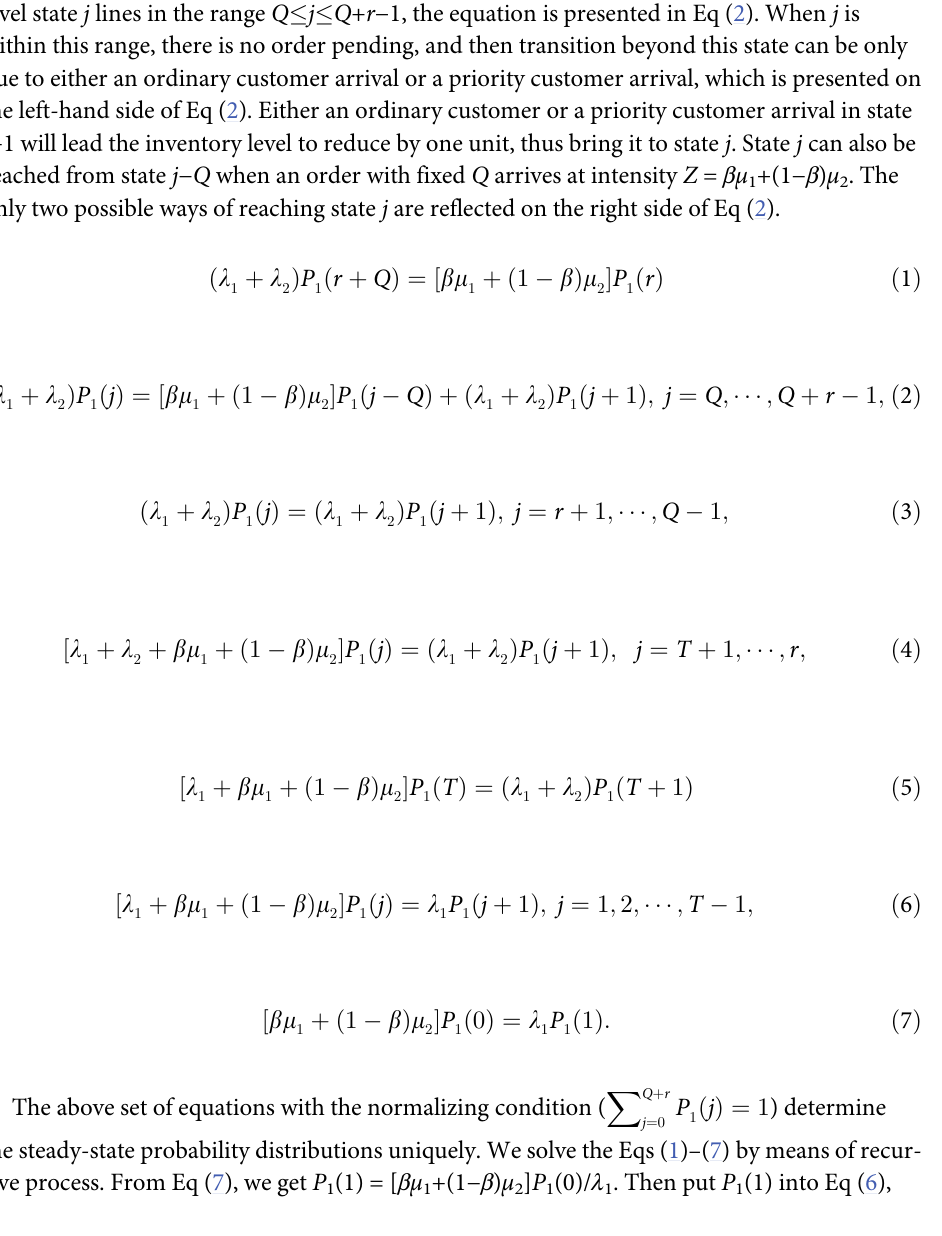
The above set of equations with the normalizing condition ( the steady-state probability distributions uniquely. We solve the Eqs (1)–(7) by means of recur- sive process. From Eq (7), we get P